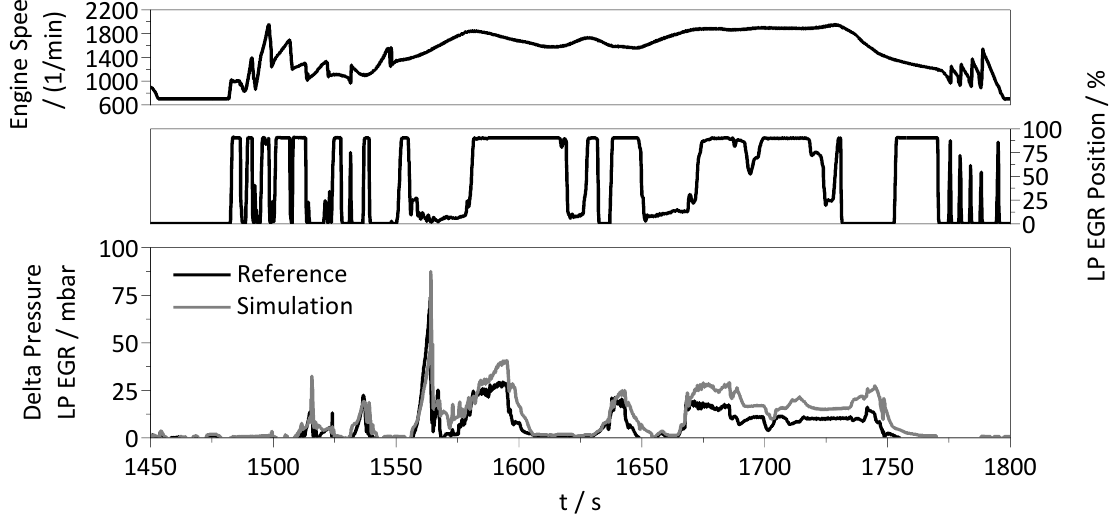
Figure 8. Verification of the 0D SRM compared to reference measurements. Figure 9 represents the WLTC performance data of the 0D SRM in terms of lambda ( λ ), CO 2 mass flows, and cumulative values compared to the corresponding measure- ments.